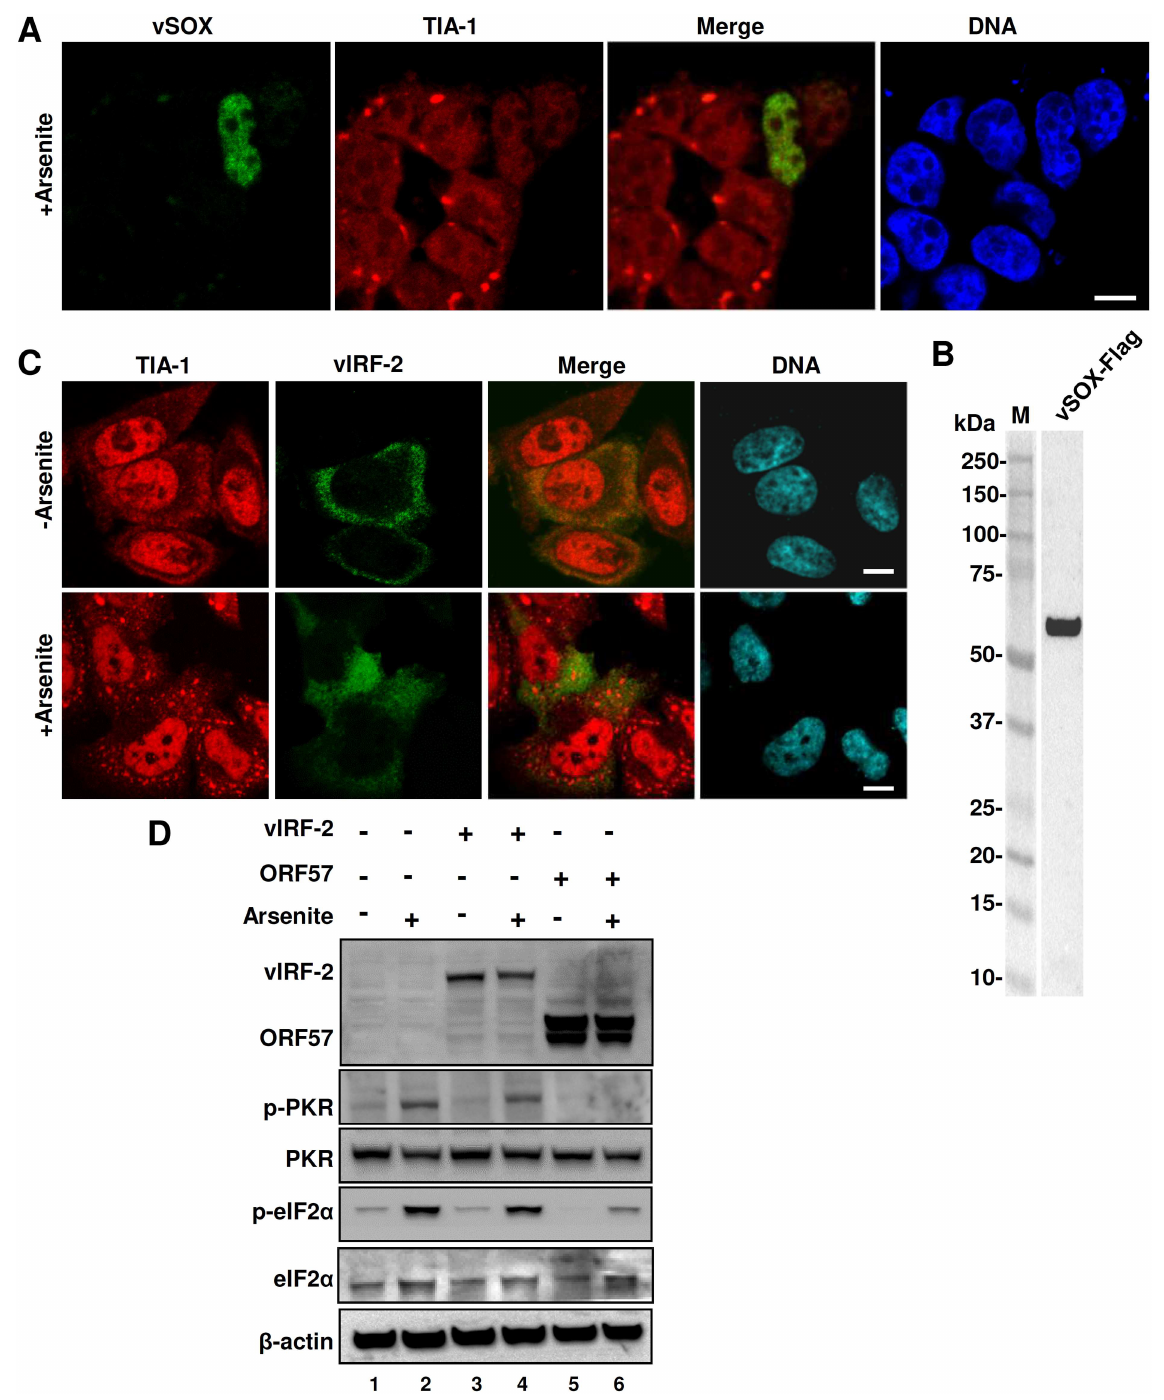
Fig 9. KSHV ORF37 (vSOX) inhibits arsenite-induced SG formation, but KSHV vIRF-2 does not. (A-B) KSHV ORF37 (vSOX) protein disrupts SG formation in HEK293 cells. HEK293cells transfected with a vSOX-FLAG expressionvector for 24 h were inducedby arsenite for SG formation, fixed and stainedwith an anti-TIA-1 antibody (red) and an anti-FLAG antibody(green) for vSOX expression. The nucleiwere counterstained with Hoechst dye (A). The cell lysates were blotted by an anti-FLAG antibody for vSOX protein (B). (C-D) KSHV vIRF2 does not inhibit SG formation and PKR phosphorylation. HeLa cells transfected for 24 h with an empty vector or a vector expressingKSHV vIRF2 or ORF57 were treated with arsenite to induceSG formation. Part of the transfected cells were used for IFA staining of SG-specific TIA-1 (red) in combination with anti-FLAG staining of vIRF2-Flag (green) (C) and other part of the cells were used for Western blotting (D). The nuclei were counterstained with Hoechst stain (C).